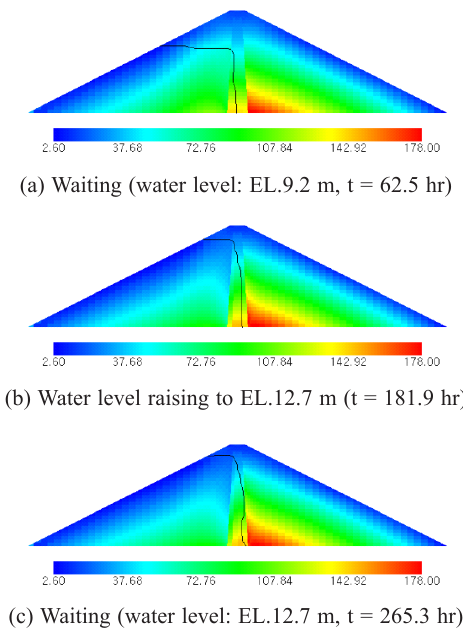
Fig. 9. Phreatic lines and distributions of mean skeleton stress with time (Case 1; unit: kPa)